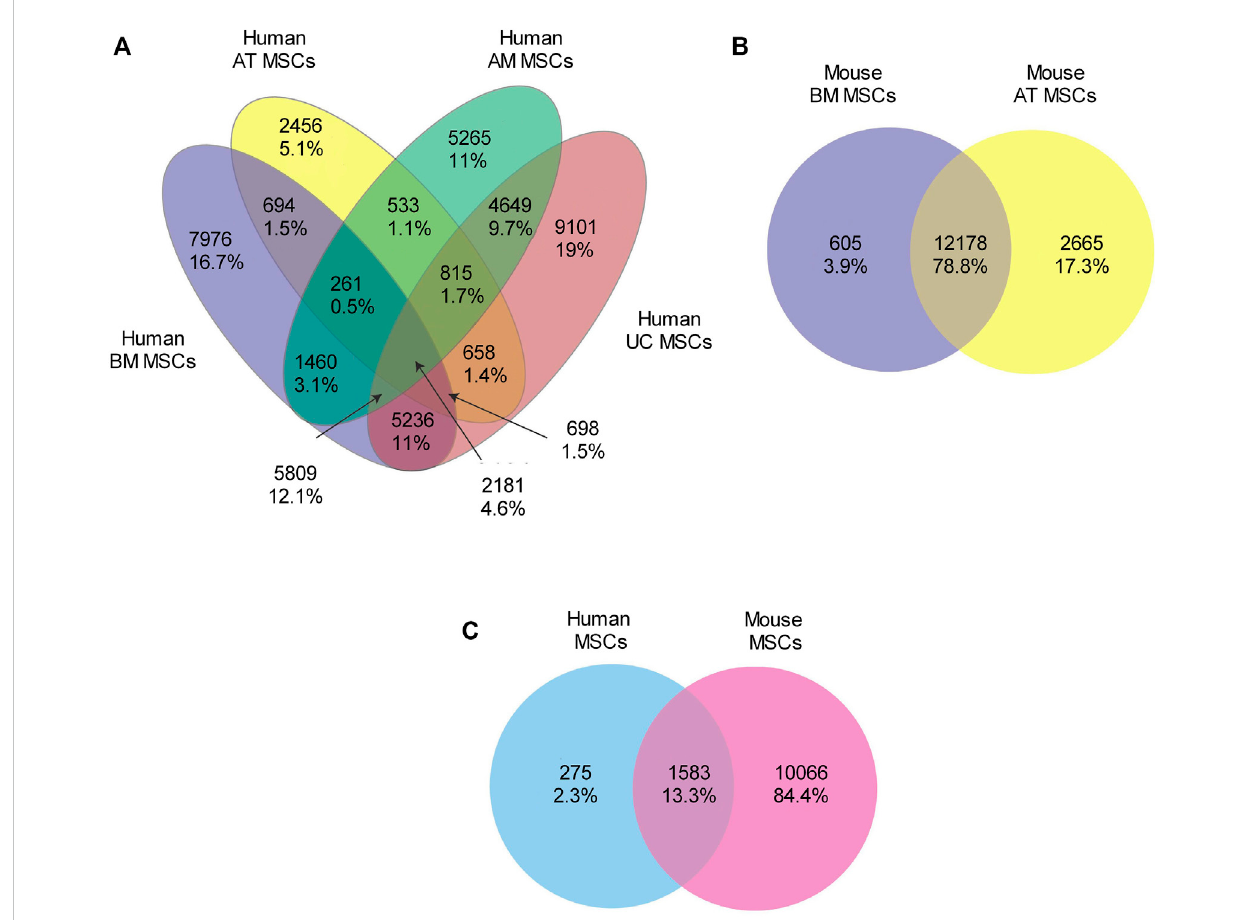
FIGURE 2 Venn diagram of the shared and unique DEGs in the transcriptomes of the MSCs derived from different tissues and species. (A) The shared DEGs in the transcriptomes of MSCs derived from four tissue types of human origin are 2,181 (4.6%). (B) The shared DEGs between the mouse BM_MSCs and the AT_MSCs are 12,178 genes (78.8%). (C) The common DEGs between human and mouse MSCs are 1,583